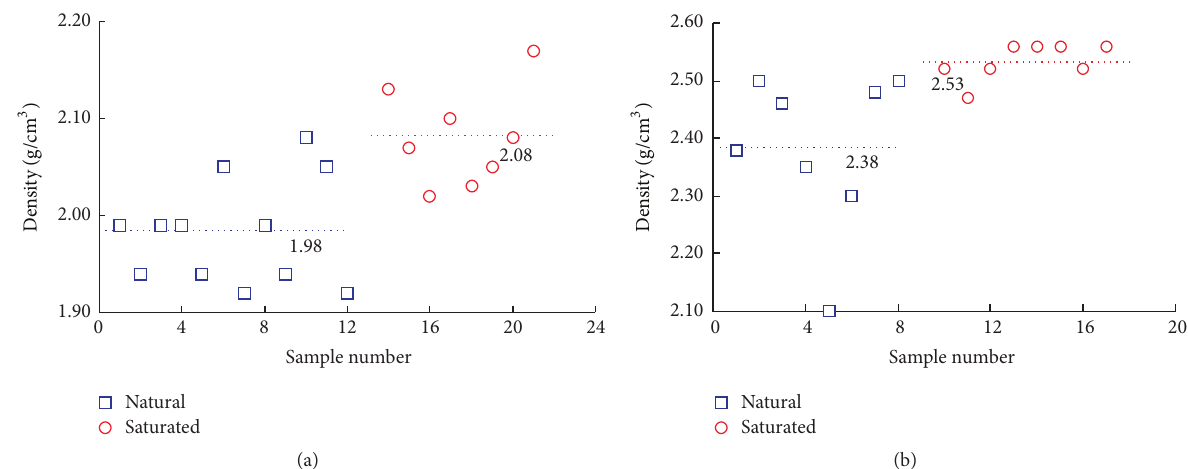
Figure 4: Test results for the density of the Zigong argillaceous siltstone under different conditions: (a) highly weathered and (b) moderately